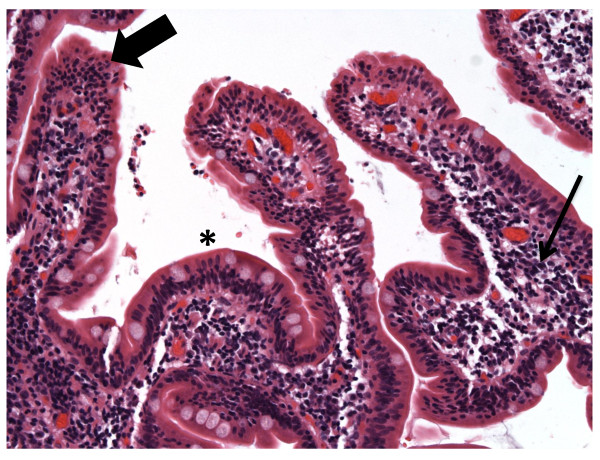
Duodenal biopsy at presentation demonstrating regions of IEL (large arrow) with normal appearing LP (small arrow) and interspersed areas of villous blunting (*).